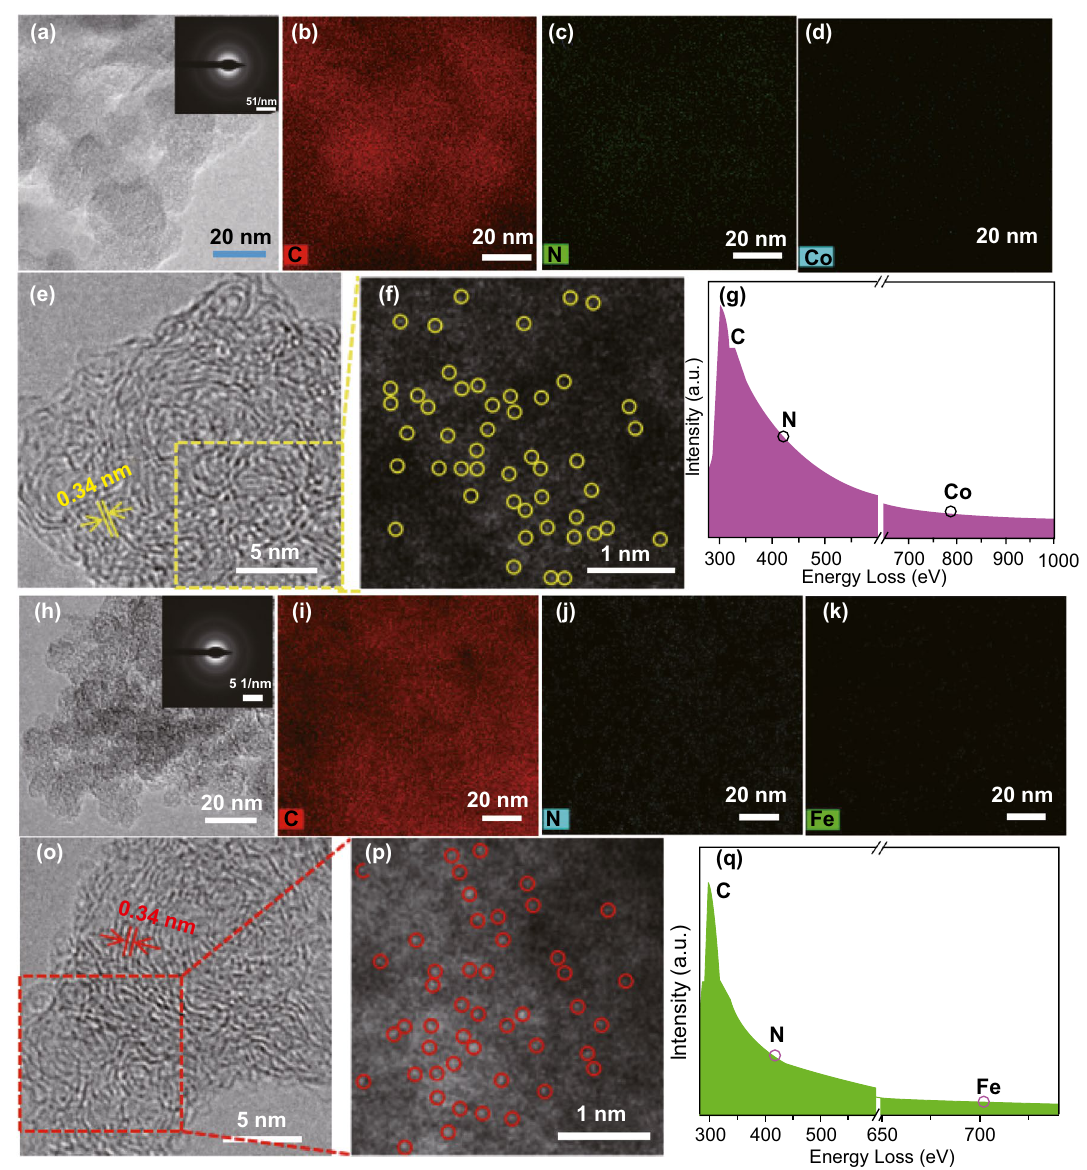
Fig. 2 a – d TEM image of Co-N 4 /NC (inset: SAED pattern) and elemental mapping of Co, N, and C. e HR-TEM (bright field). f Aberration- corrected HAADF-TEM image. Enlarged pattern of Co-N 4 /NC and partial single Co atoms (yellow). g EELS atomic spectra of Co, N, and C elements corresponding to f . h – k TEM image of Fe-N 4 /NC (inset: SAED pattern) and elemental mapping of Fe, N, and C. o HR-TEM